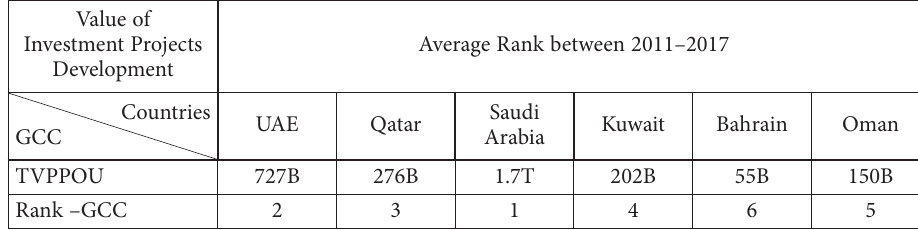
2011–2017Value of Investment